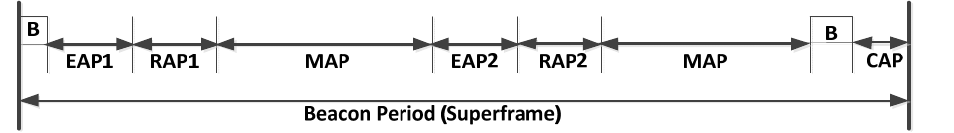
Figure 9. Layout of Access Phase in a Beacon Period (Superframe) for Beacon Mode [9].